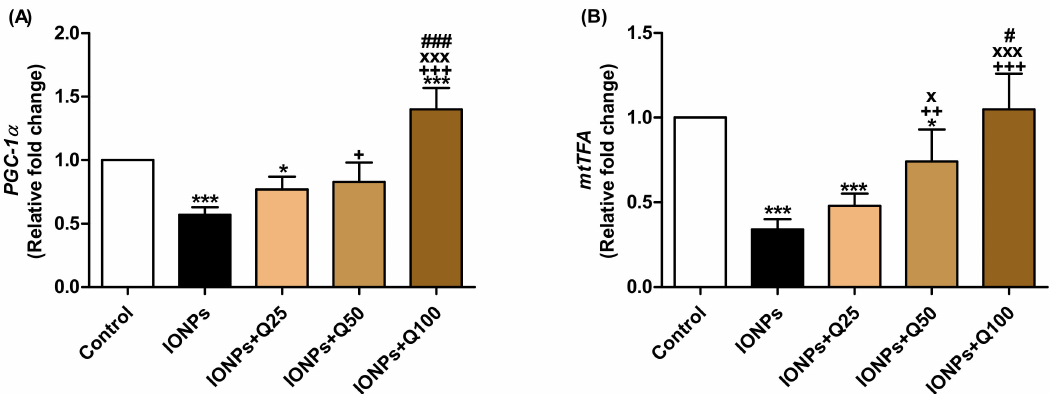
Figure 5. mRNA relative fold change expression of brain tissue. ( A ) PGC-1 α . ( B ) mtTFA . Data were analyzed with a one-way ANOVA followed by Tukey’s multiple comparison test. * p < 0.05 and *** p < 0.001 vs. the control. ++ p < 0.01 and +++ p < 0.001 vs. IONPs. x p < 0.05 and xxx p < 0.001 vs. IONPs + Q25. # p < 0.05 and ### p < 0.001 vs. IONPs + Q25. Error bars represent mean ± SD. n = 5. White color column refers to control. Black color column refers to IONPs. Colored column with different extents refers to different concentrations of quercetin supplementations to IONPs-treated